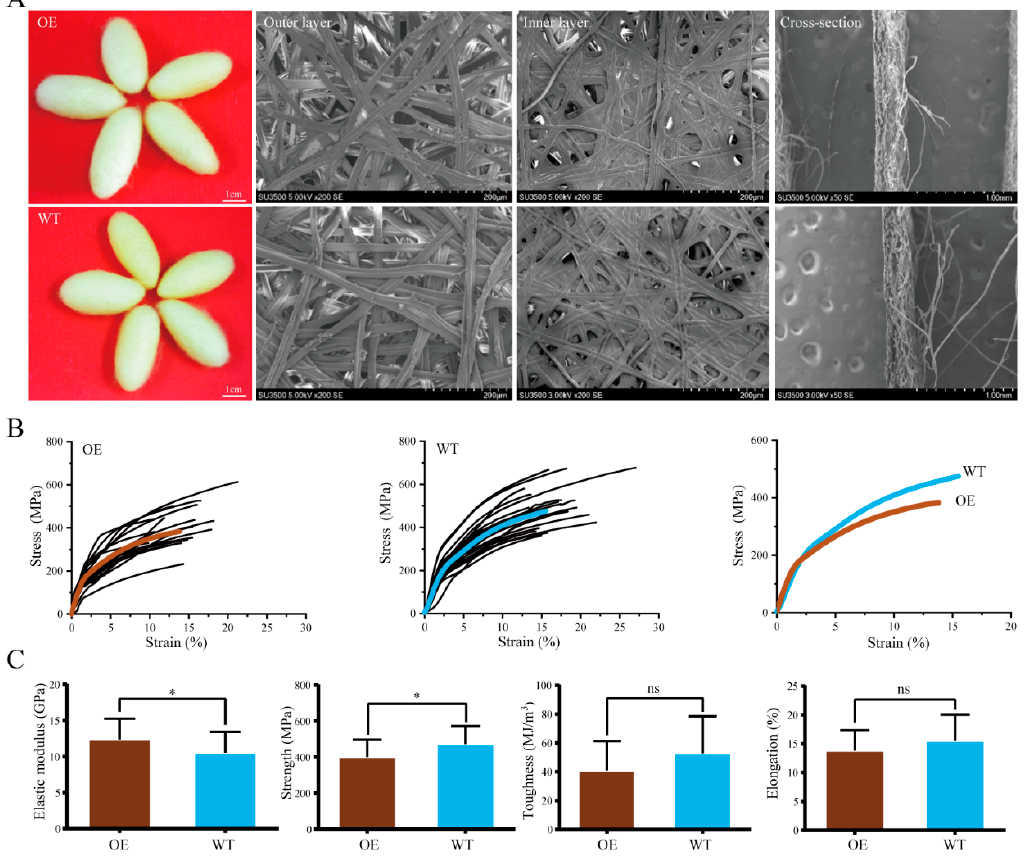
Figure 4. Comparison of phenotypes and mechanical properties of silks from the OE and WT. ( A ). The phenotype of cocoons and silk fibers of the OE and WT. ( B ). Stress–strain curves of the silk fibers. ( C ). Toughness, maximum strength, toughness, and elastic modulus. Error bars, SD; * p < 0.05.